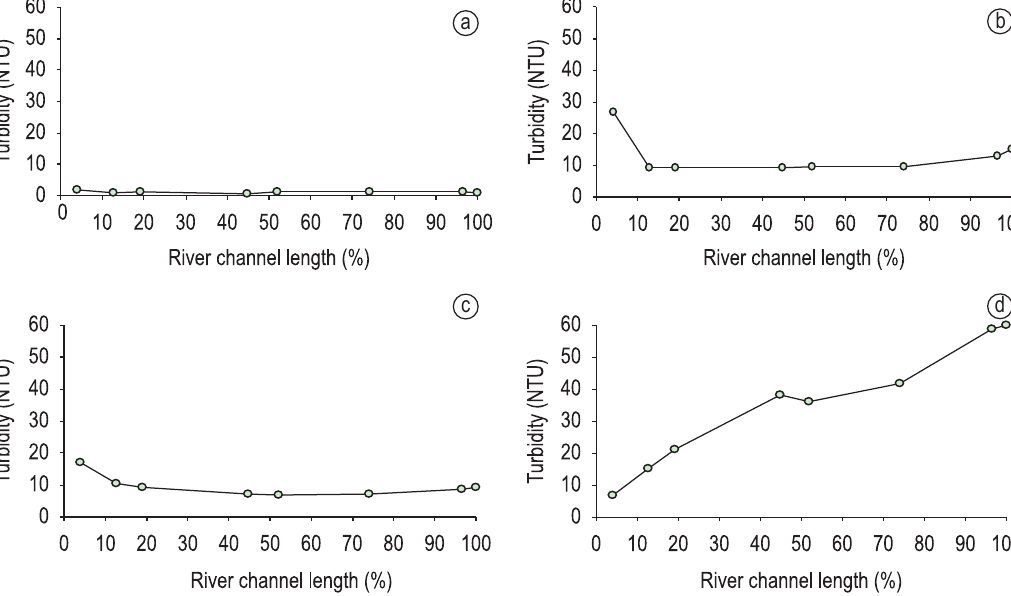
Figure 8. Turbidity variation (NTU) in Canha River, during the spring (a - September), summer (b - January), autumn (c - April) and winter (d - July) periods, respectively. ● : observed